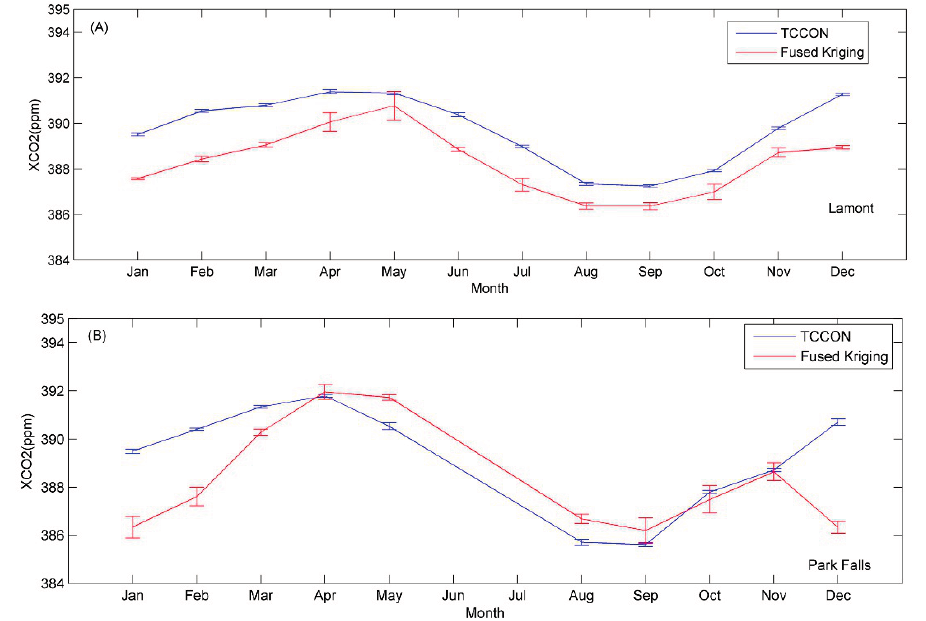
Figure 6. Error bars are pure statistical uncertainties of the monthly means (±3 sigma/sqrt( n ) for TCCON site and fused Kriging data within ±2.5° in 2010; for TCCON sites, the monthly data between 10 am and 2 pm are averaged according to the overpass time of two satellites being combined. ( A ) Lamont site in 2010; ( B ) Park Falls site in 2010; ( C ) Garmisch site in 2010; and ( D ) Wollongong site in